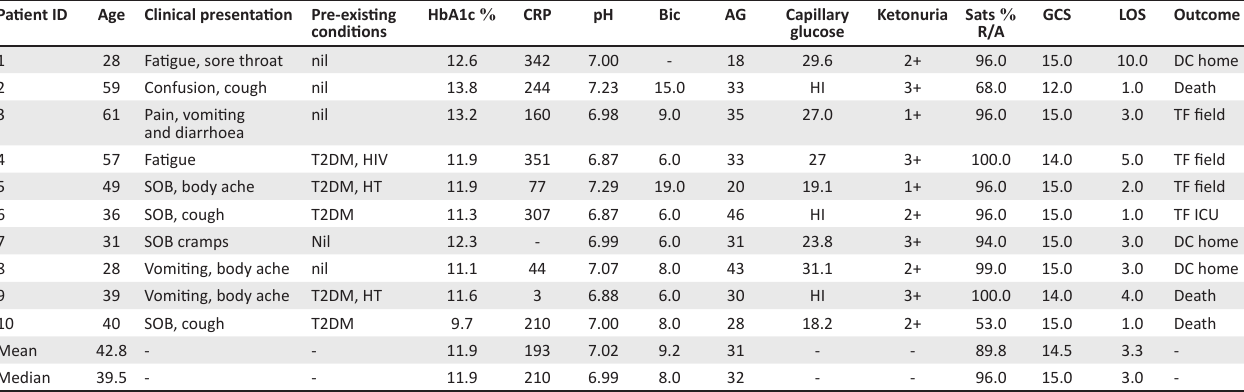
TABLE 2: Biochemical markers on presentation and clinical outcome. Patient